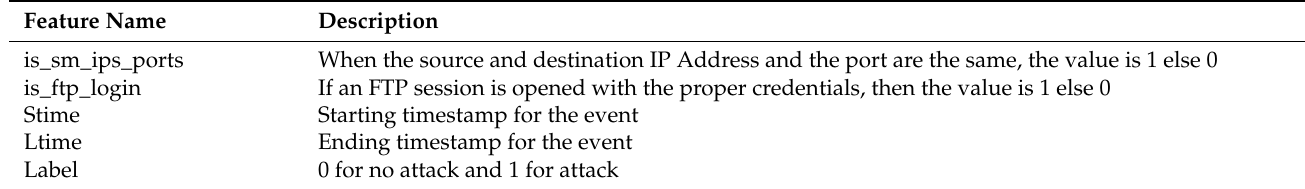
Table 4. Binary and timestamped